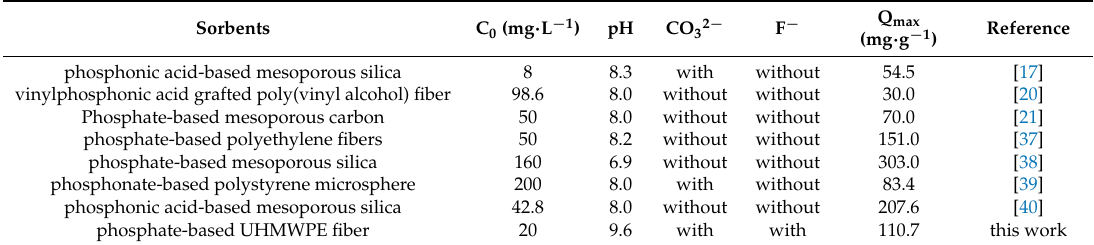
Table 4. U(VI) adsorption performance of UHMWPE-g-PO 4 fibers compared with other adsorbents containing phosphate or phosphonic acid